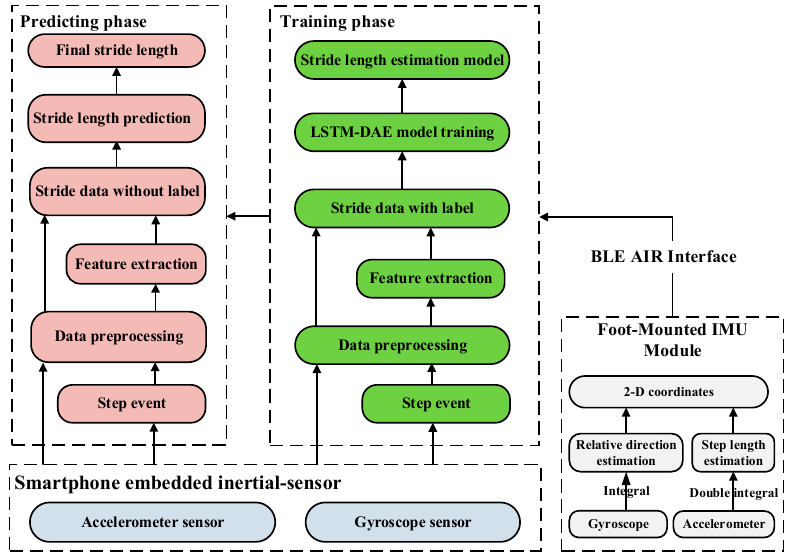
Figure 2. System architecture of the proposed TapeLine.